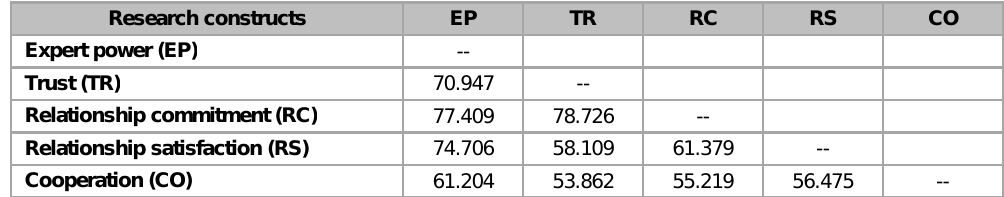
Chi-Squire differences (constrained-unconstrained) in all two-factor CFA tests